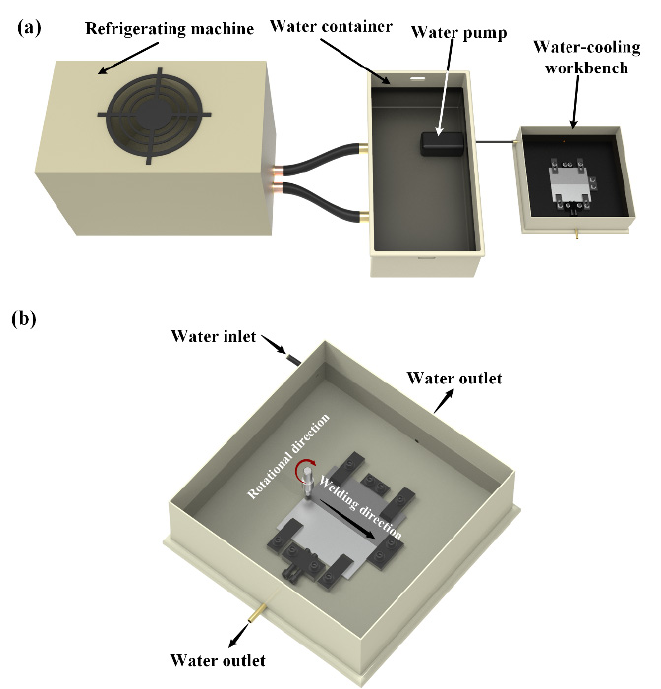
Figure 1. Schematics of the SFSW: ( a ) cooling system, ( b ) welding fixture.